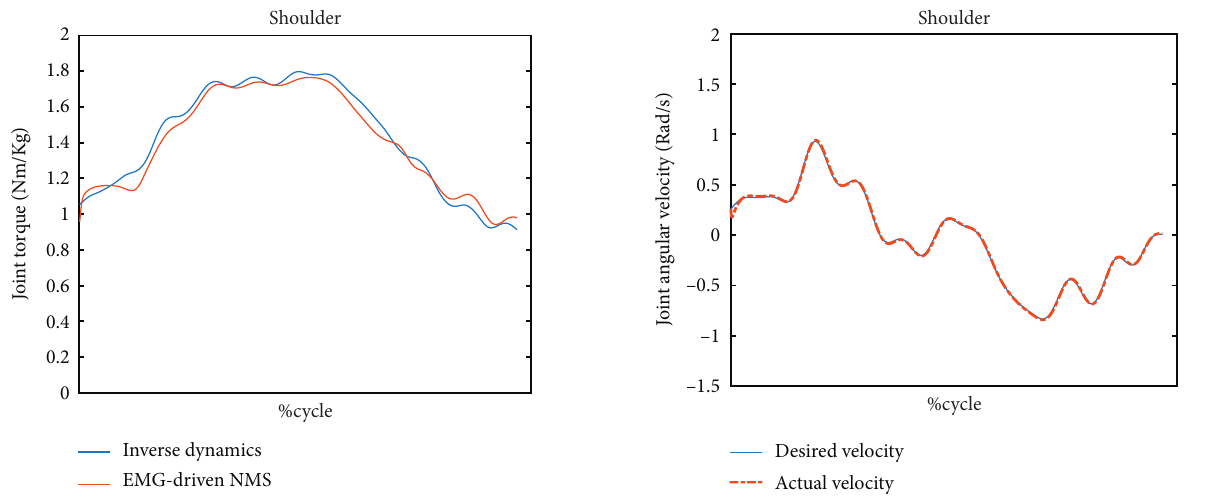
Figure 5: The desired and actual angular velocity of the shoulder.